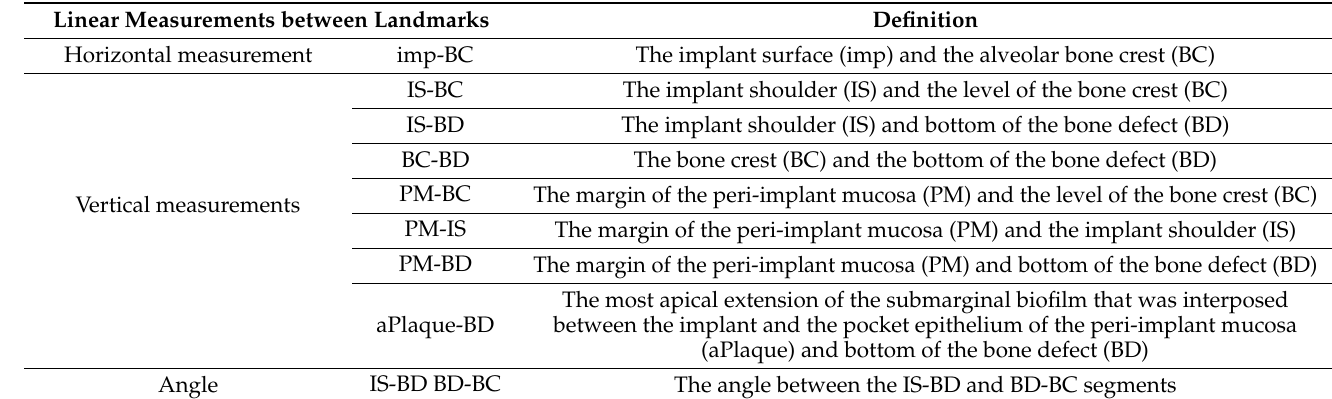
Figure 2. Histomorphometric landmarks identified on both buccal and lingual aspects in each implant: 1—implant shoulder (IS); 2—implant surface at the level of the bone crest (imp); 3—bone crest, defined as the most coronal point of the bone (BC); 4—bottom of the bone defect (BD); 5—margin of the peri-implant mucosa (PM); 6—the most apical extension of the submarginal biofilm that was interposed between the implant and the pocket epithelium of the peri-implant mucosa (aPlaque). Table 1. Linear measurements between the landmarks on both aspects of the thin and thick